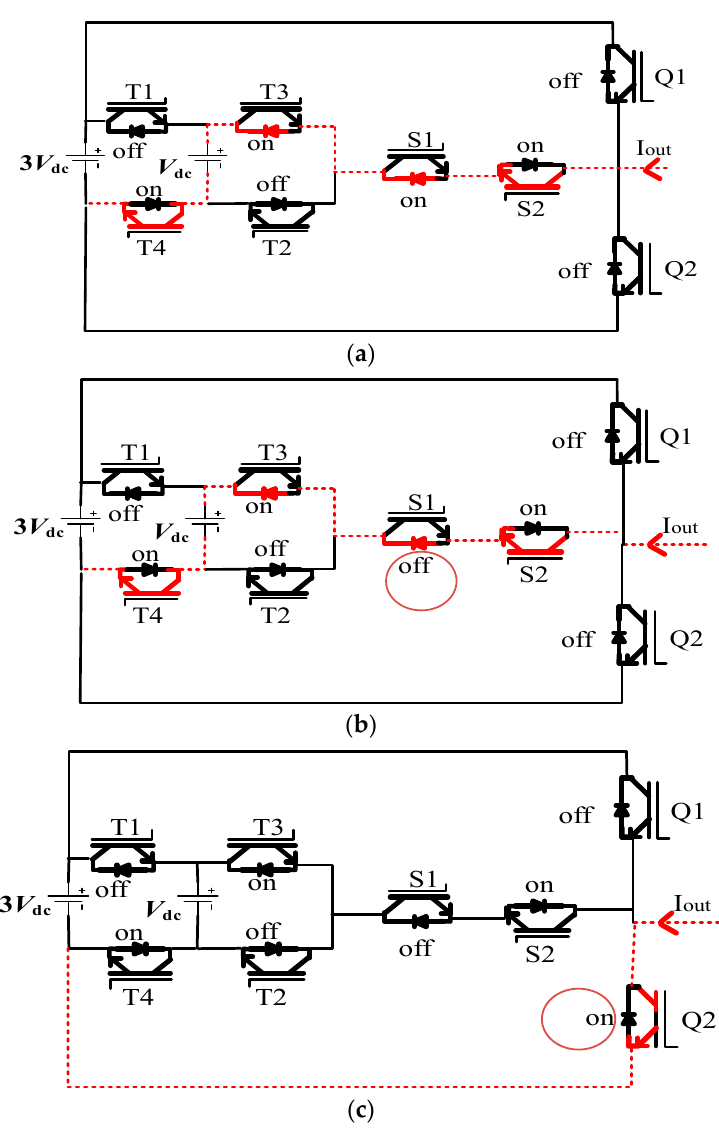
Figure 4. Current commutation during switching transition of negative output current in leg a . ( a ) Output voltage level of V dc (Q2 off and D S1 on). ( b ) Output voltage level of V dc (Q2 off and S 1 off on ZVS). ( c ) Output voltage level of 0 (Q2 on and S 1 off).